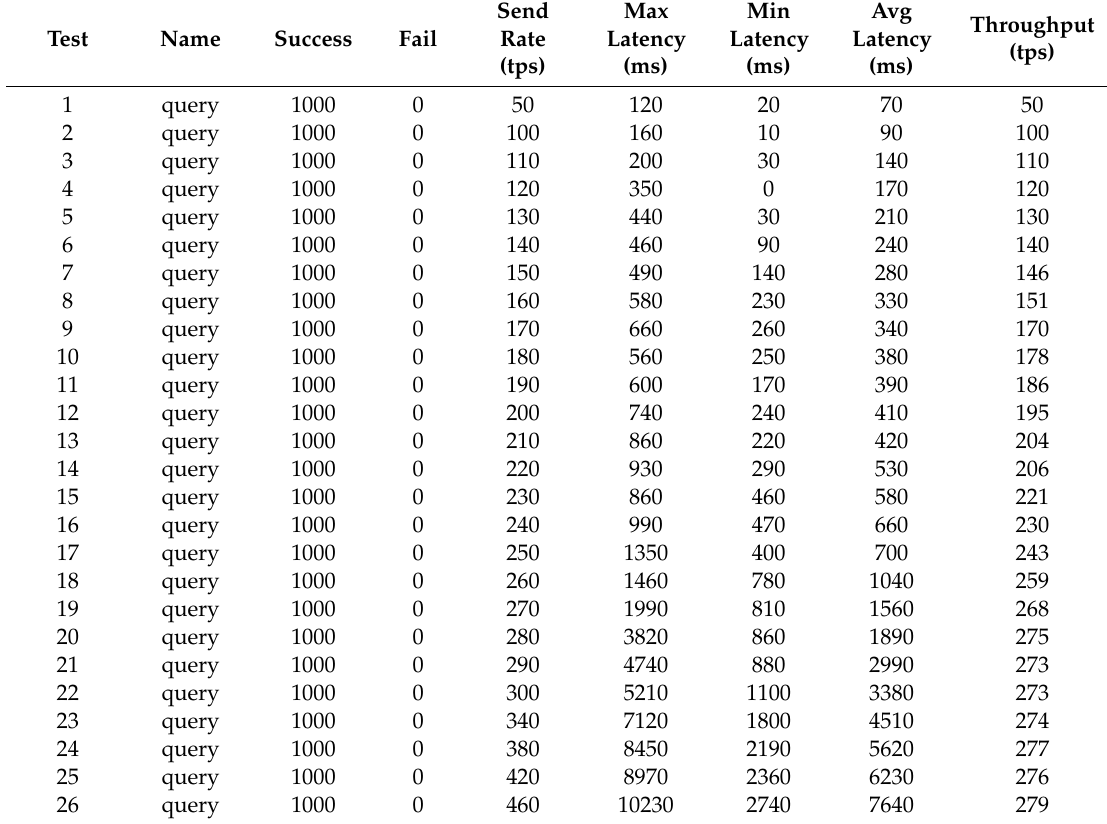
Table 14. Caliper’s pressure test